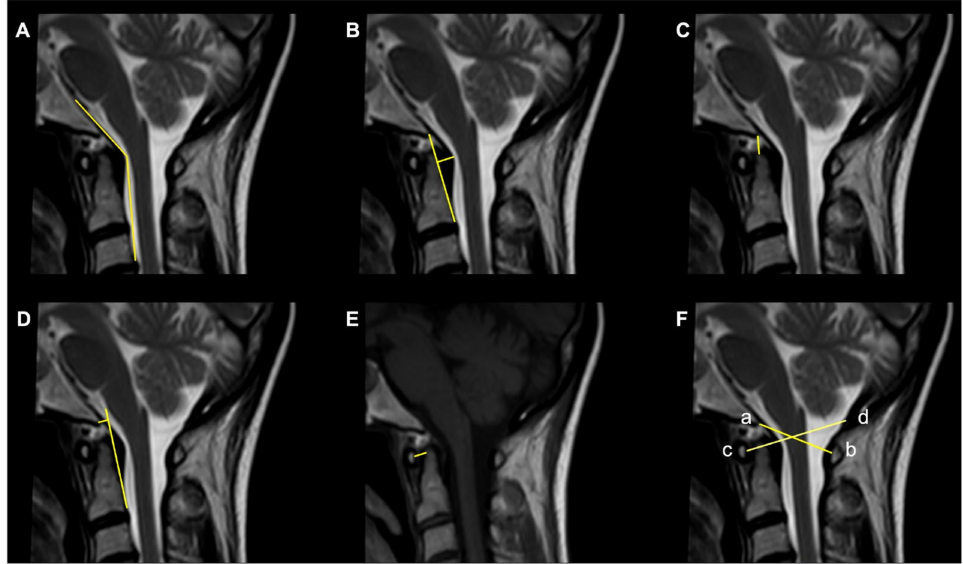
Figure 3. Commonly used radiological parameters to predict CVJ instability. ( A ) Clivoaxial Angle (CXA). ( B ) Grabb–Oakes line. ( C ) Basion–Dens Interval (BDI). ( D ) Basion–Axial Interval (BAI). ( E ) Atlantodental Interval (ADI). ( F ) Powers ratio: